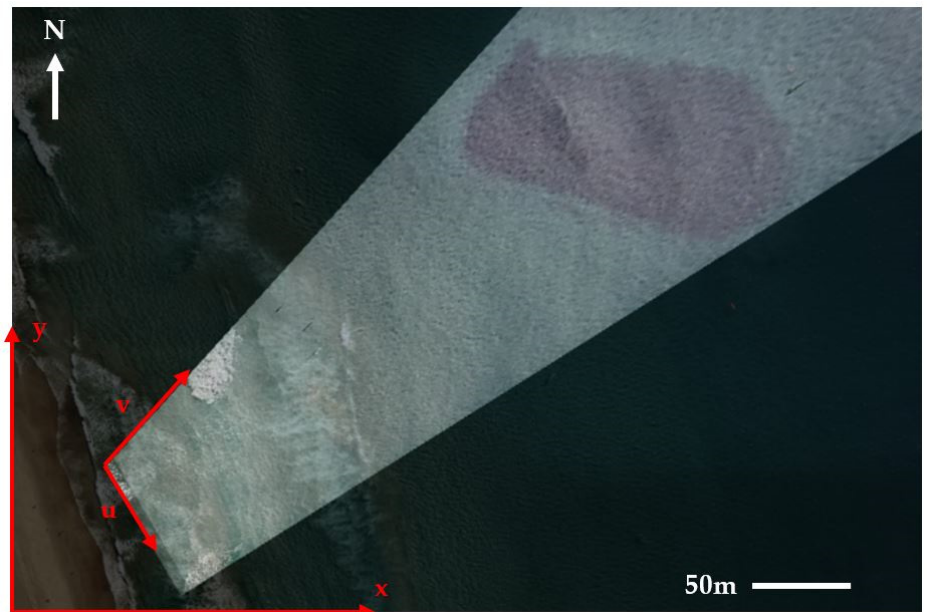
Figure 3. Homography stretching applied to an image (note that the map image is not from the same date as the video image, so sand bars are not expected to line up). The reef is visible as the dark oblong in the upper right of the image.